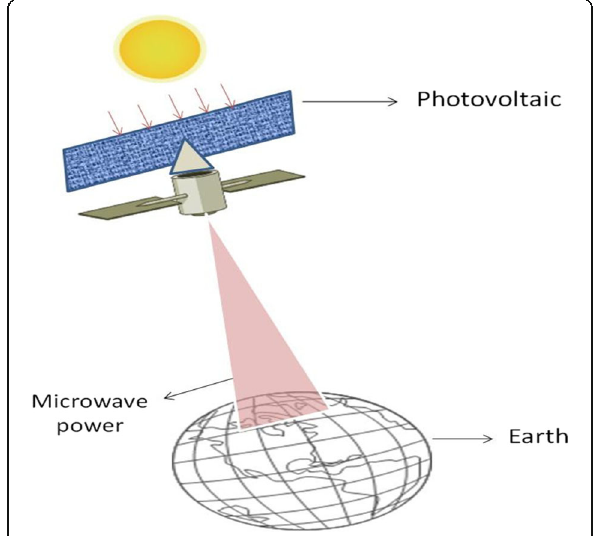
Fig. 2 Space-based solar